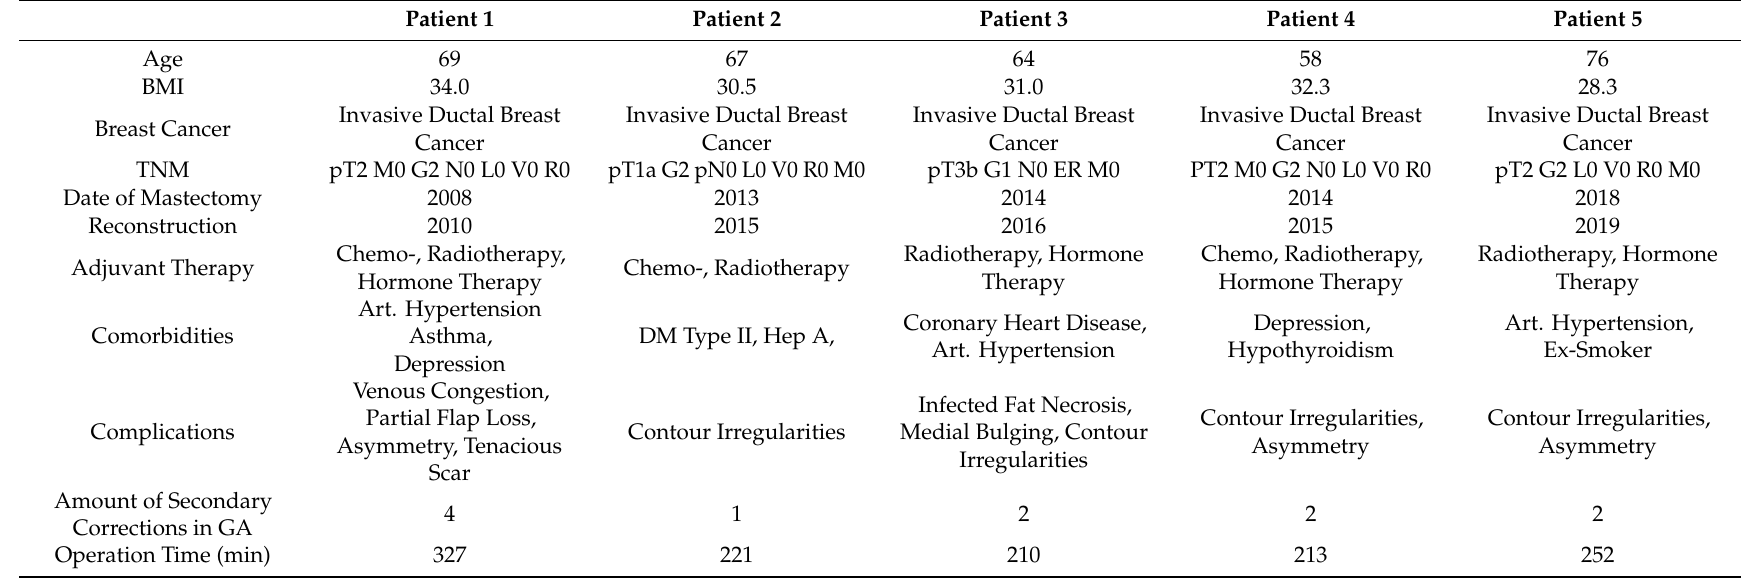
Table 1. Patient characteristics and